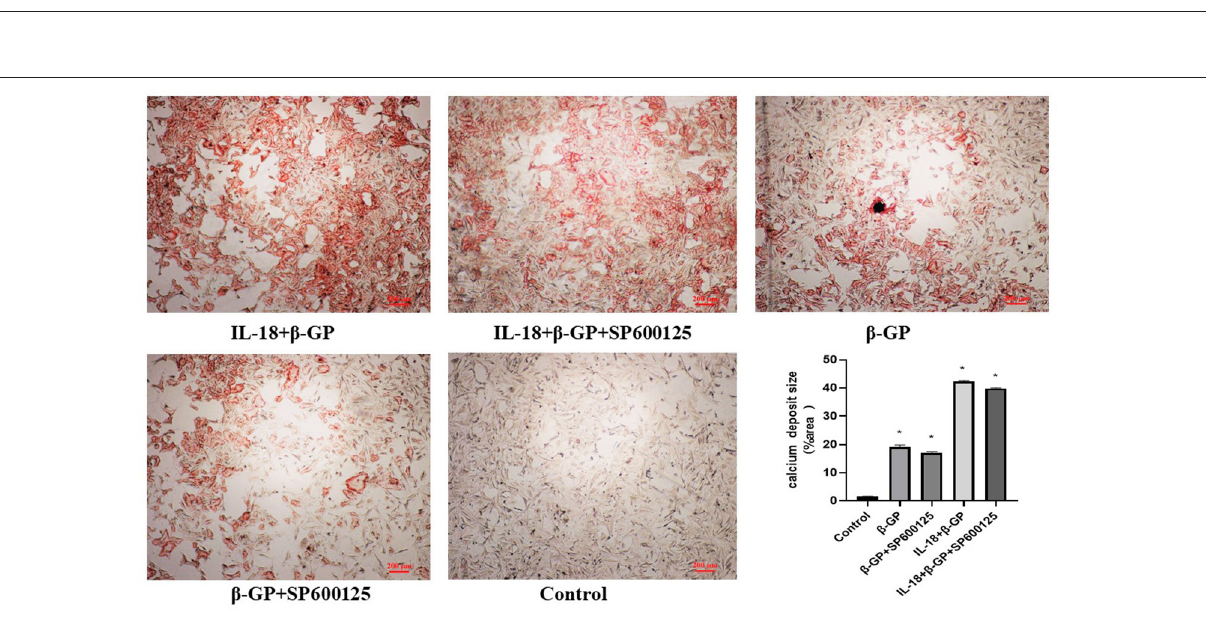
Frontiers in Cardiovascular Medicine |